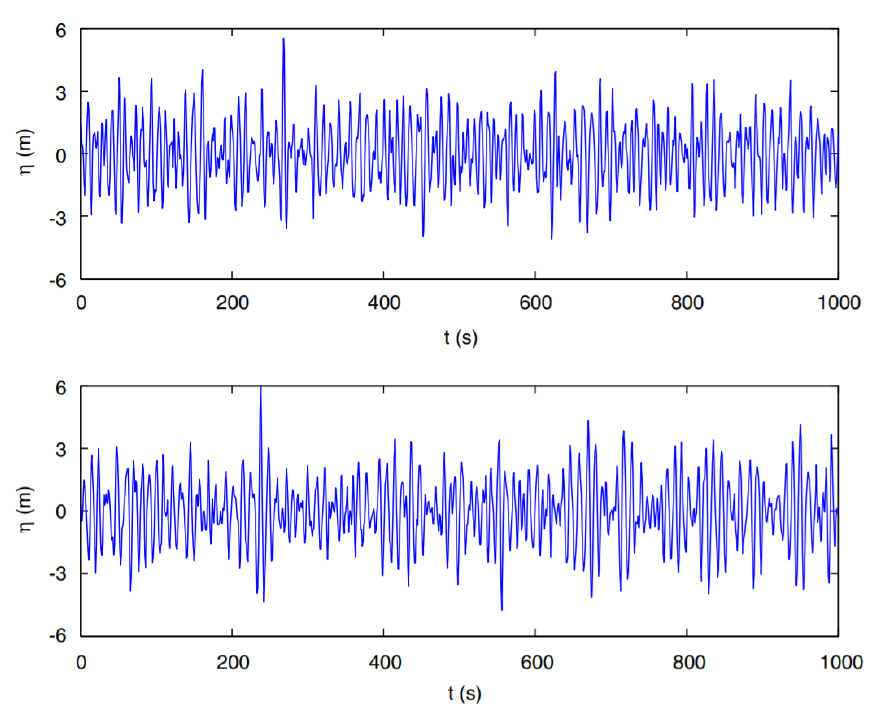
Figure 17. Time history of simulated random wave profiles using B-M Spectrum ( upper panel ) and JONSWAP Spectrum ( lower panel ).